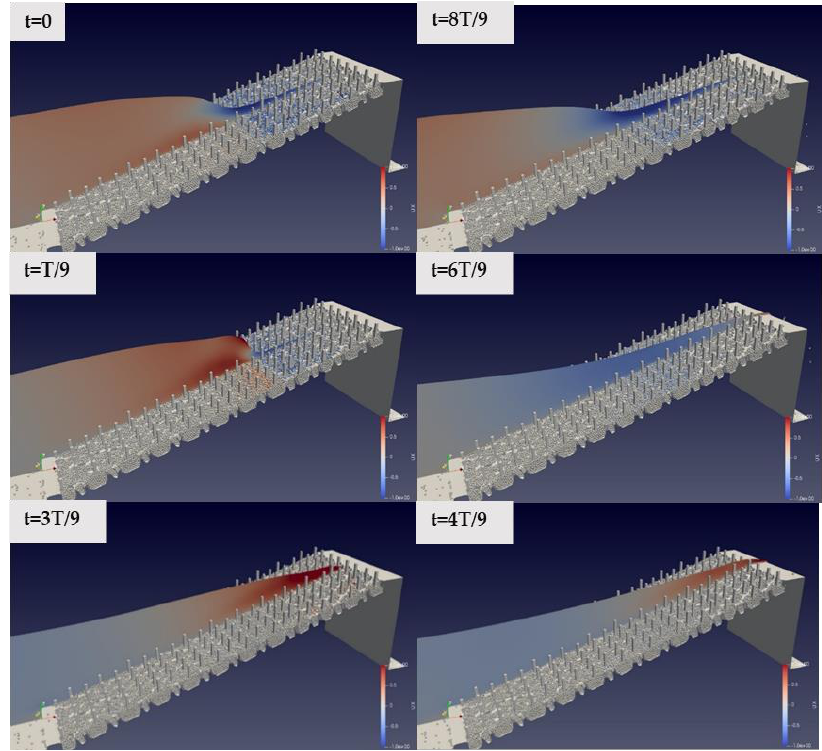
Figure 4. The process of wave run-up and wave overtopping simulated by the numerical model. Table 2. Comparison between the run-up height of the experiments and that of the numerical sim- ulation (Unit: m).